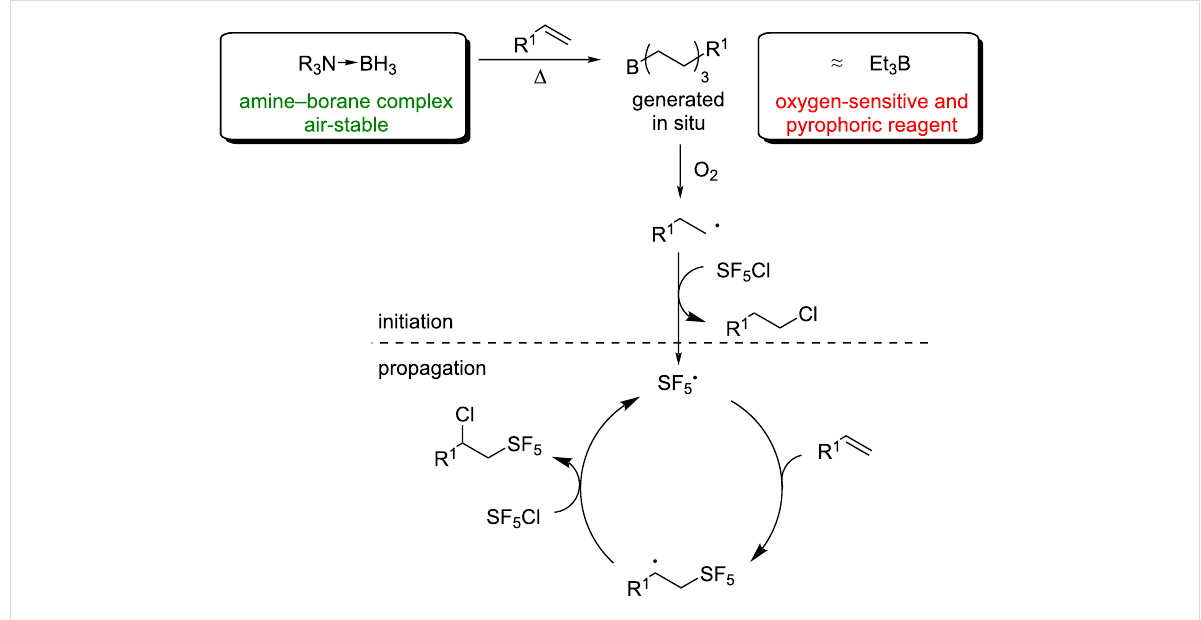
We started the optimization with DIPAB as the amine–borane complex. To our delight, in all tested solvents and